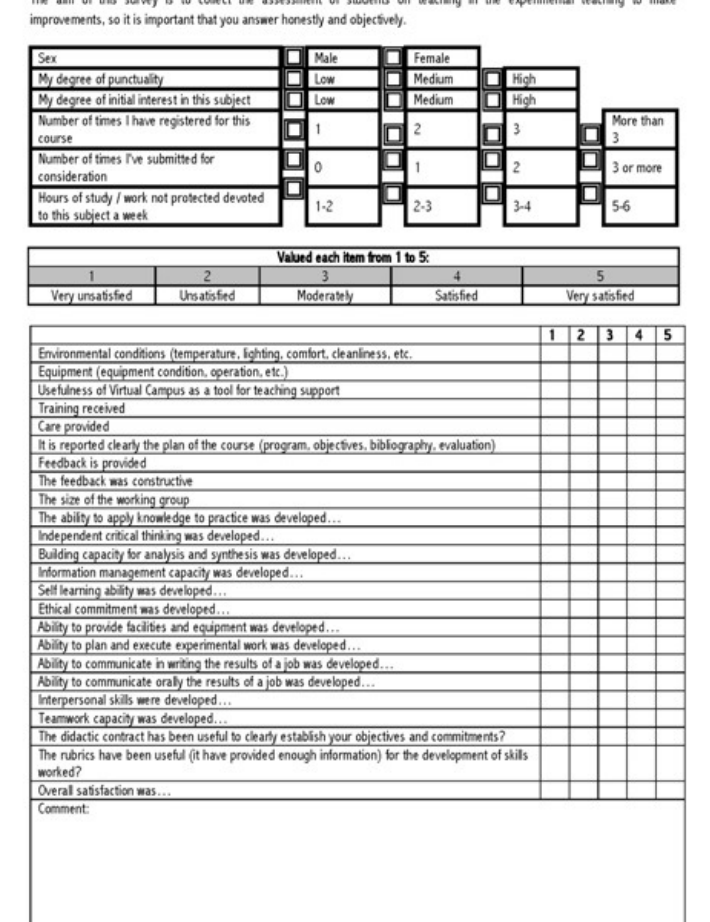
Figure 1. Student satsfacton